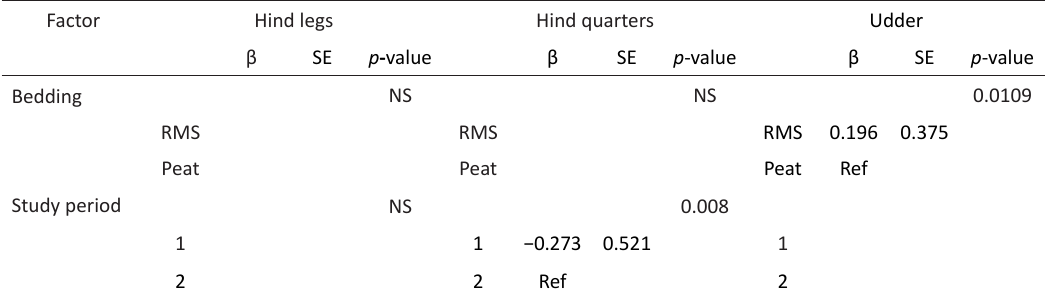
Table 5. Model estimates describing the factors influencing the cleanliness of the cows with β , standard error (SE) and significant p -values. No interactions are presented since none of them were statistically significant. The GLIMMIX procedure modeled the probabilities of levels of cleanliness having lower ordered